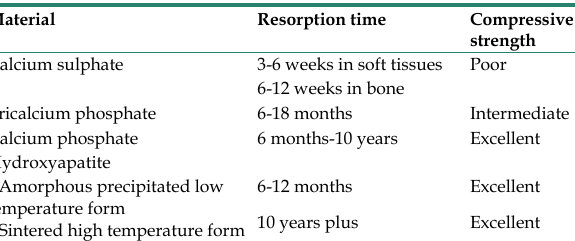
Table 2. Resorption times for various ceramic carriers.